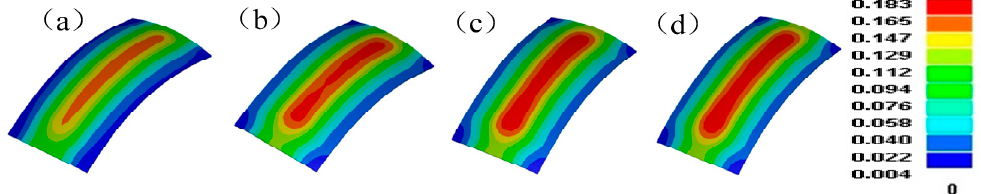
Figure 5. The plastic strain of formed part with different rotation speed ratio ( a ) 1:1, ( b ) 1:1.05, ( c ) 1:1.10, and ( d ) 1:1.15.